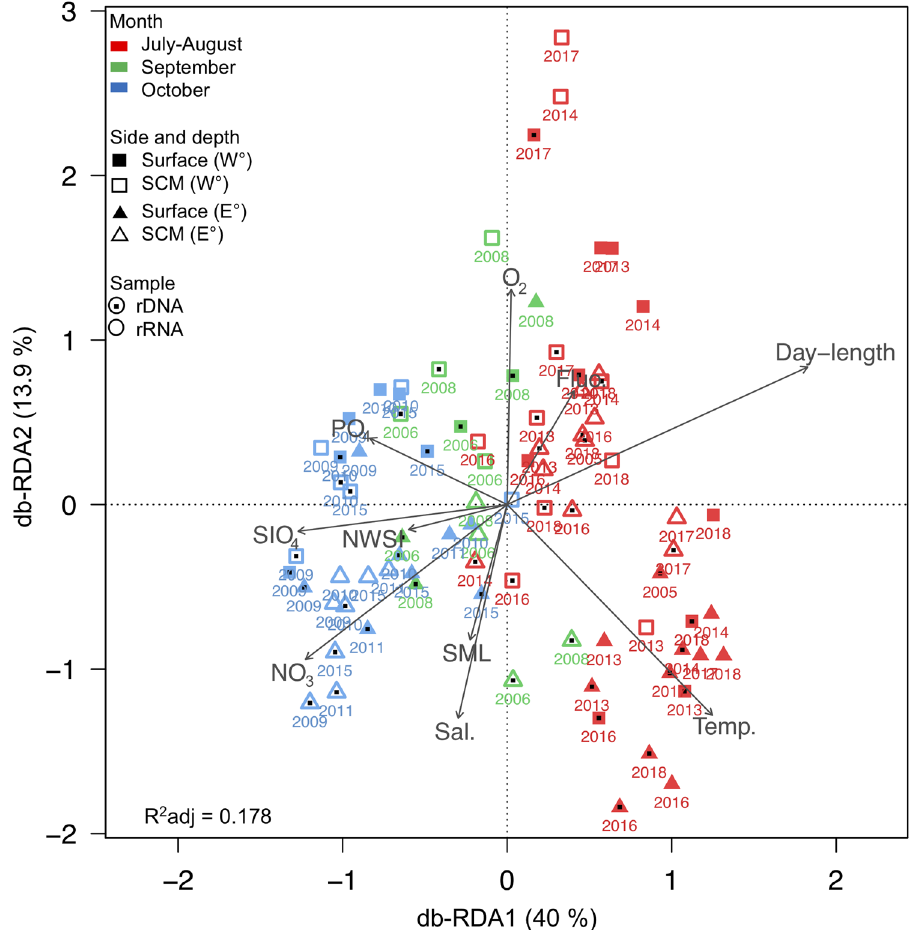
Figure 3. Microbial eukaryotic community clustering using distance-based Redundancy Analysis (db-RDA) with the Bray–Curtis dissimilarity measure. Arrows indicate correlation between environmental parameters and communities assembled from rRNA (open symbols) and rDNA (symbols with interior dots), for the two sides of the North Water: Canada on the Western (W°) and Greenland on the eastern side (E°). Colors indicate month of sampling. Significant factors were water temperature (Temp.), salinity (Sal.), relative Chl a fluorescence (Fluo.), nitrate (NO 3 ), silicate (SiO 4 ) and phosphate (PO 4 ) concentration, dissolved oxygen (O 2 ), depth of surface mixed layer (SML; Supplementary Table S2), day-length and day of the year for the onset of new winter sea-ice (NWSI) in North Water region (from Fig.